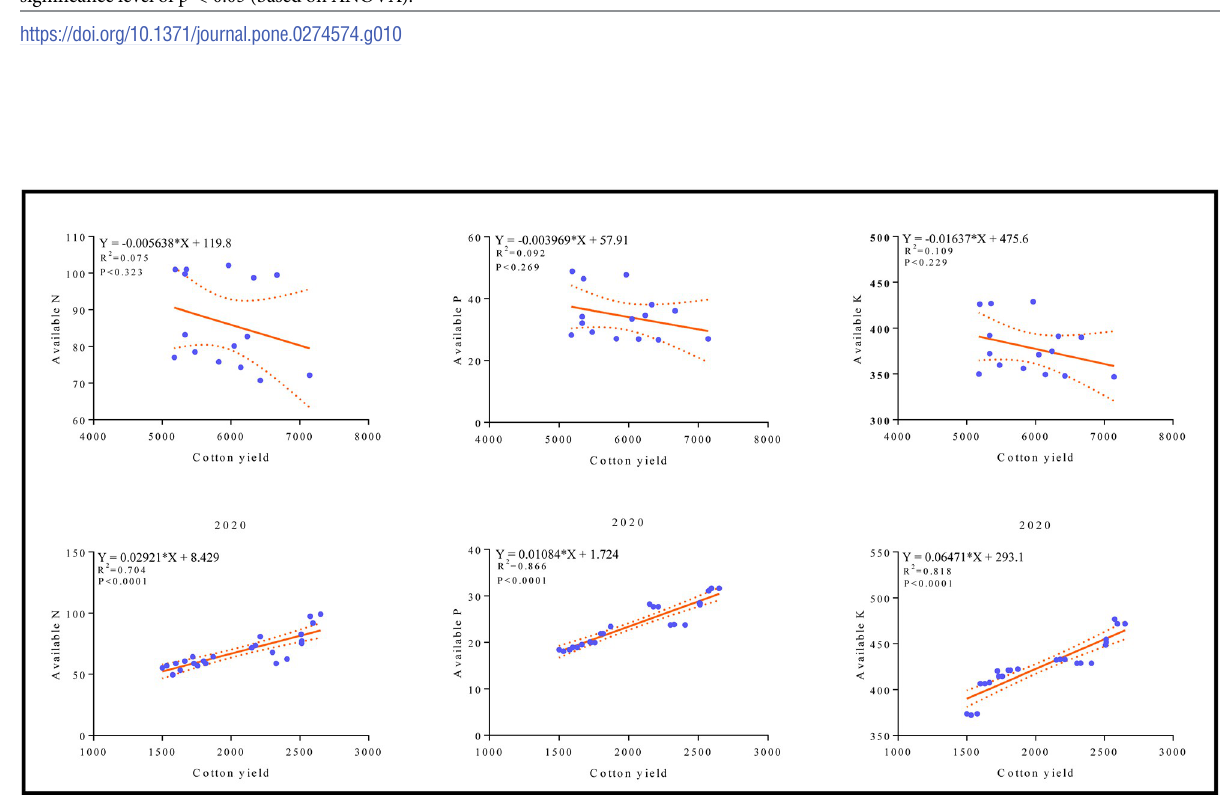
Fig 11. The relationship between soil available nutrients and cotton yield.